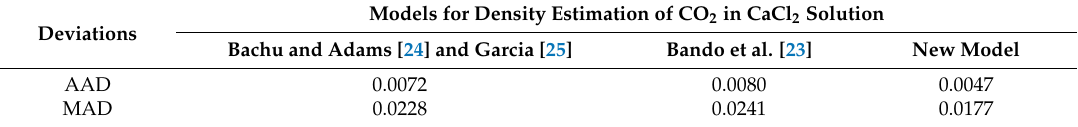
Table 5. Comparison of various model estimations for CaCl 2 solutions saturated with CO 2 to experimental data from the current study and the new model proposed in this